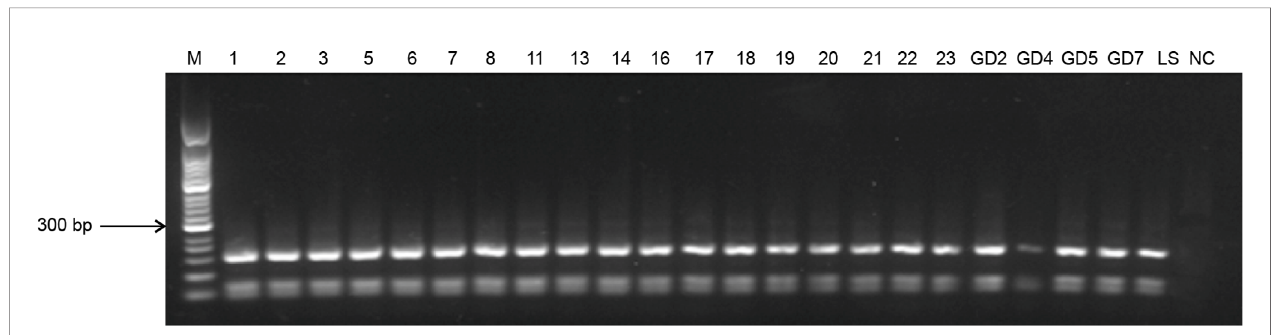
FIGURE 3 | RFLP pro fi les of ITS genes ampli fi ed from Leishmania digested with Hae III. M, 50-bp marker; 1 – 23, blood samples from infected patients and their families; GD2 – GD7, blood and tissue samples from domesticated pigs; LS, positive control; NC, negative control.